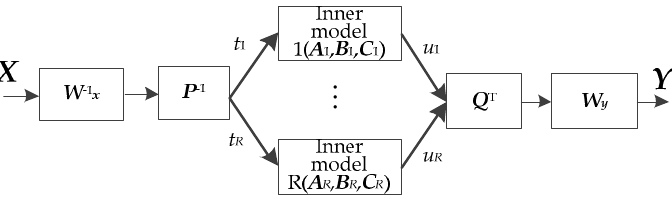
Figure 1. Structure of dynamic partial least square (DyPLS) models with state space model.